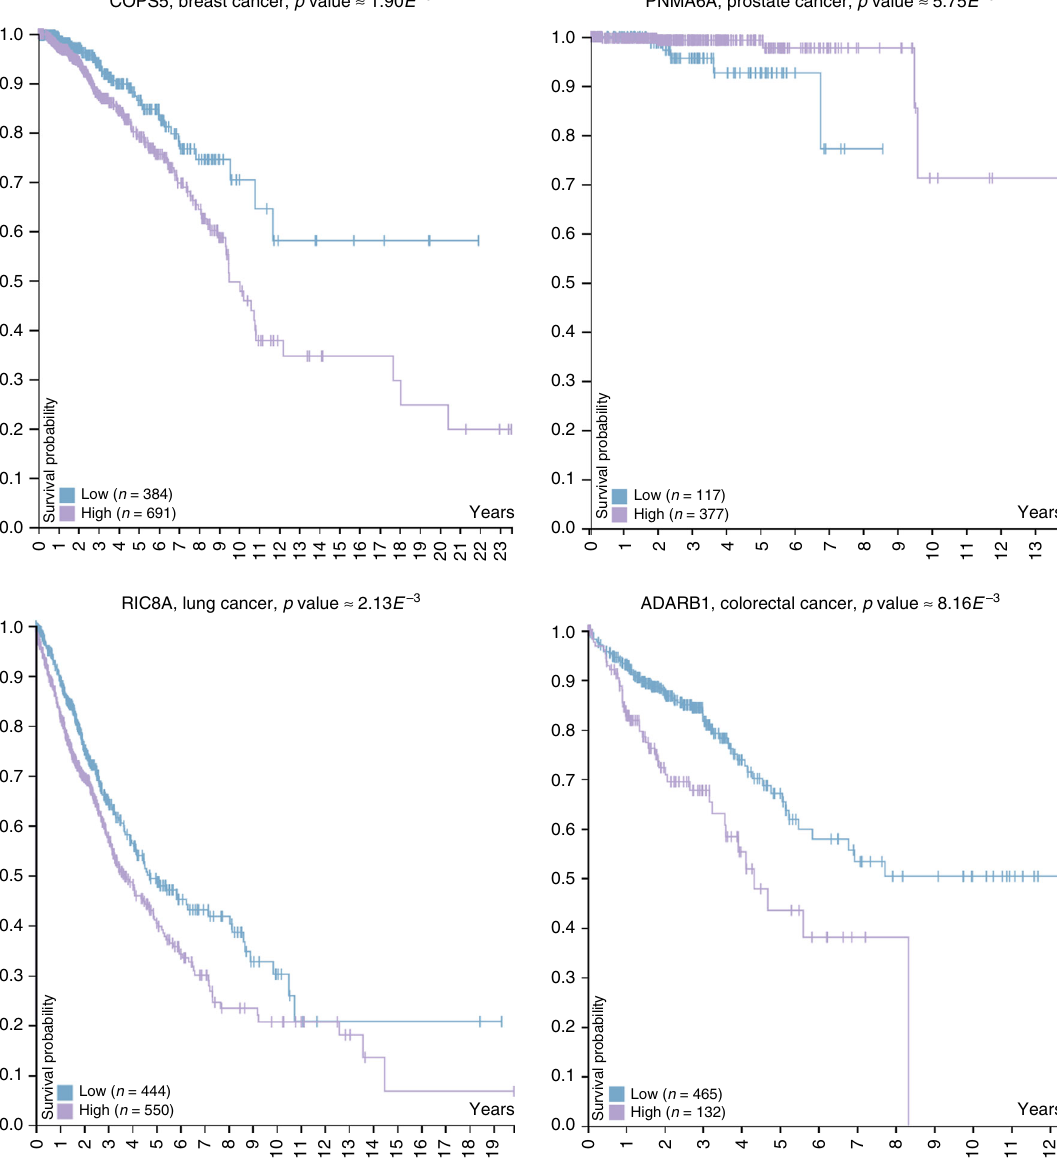
Fig. 4 Kaplan – Meier survival curve analysis. For each of the breast, prostate, lung, and colorectal cancers, panels show the Kaplan – Meier survival curves of a newly prioritized gene from our computational analysis, the expression of which in patients allows for the most statistically signi fi cantly different survival curves (log-rank p values). The plots are generated at the Human Protein Atlas web-server